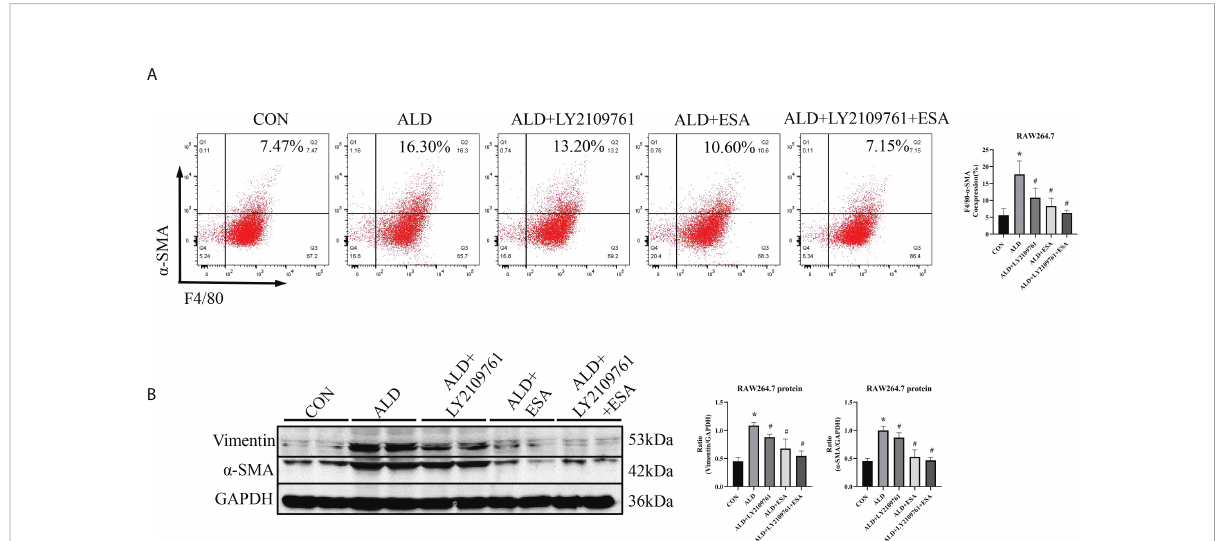
FIGURE 8 The TGF- b 1 receptor blocker LY2109761 antagonized ALD-treated MMT in RAW264.7 cells. (A) Flow cytometric analysis of the expression of a - SMA in RAW264.7 cells, and Q2 indicates the percentage of MMT cells (n = 3). (B) Western blotting analysis of a -SMA and vimentin expression in ALD-treated RAW264.7 cells (n = 6). The data are presented as the mean ± SD, *p < 0.05 vs. the CON group, # p < 0.05 vs. the ALD group. ALD, aldosterone; MMT, macrophage-to-myo fi broblast